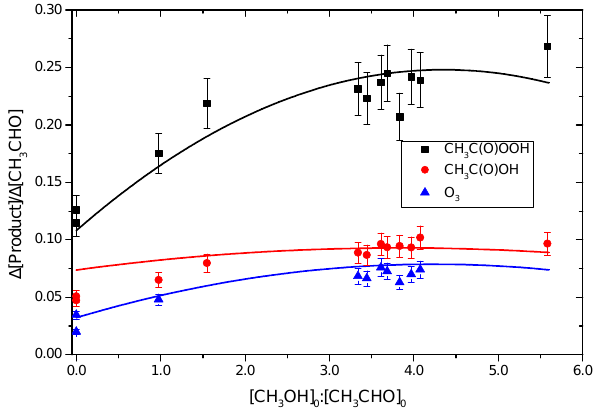
Figure 6. Experimentally determined product yields (relative to de- cay in CH 3 CHO) for CH 3 C(O)OOH, CH 3 C(O)OH and O 3 as a function of the [CH 3 OH] 0 :[CH 3 CHO] 0 ratio where each point rep- resents one experiment. Model 3 predictions for each species yield also displayed for comparison (solid lines of corresponding colour). Uncertainties calculated to 2 σ from linear regression of respective [product] vs. (cid:49) [CH 3 CHO]